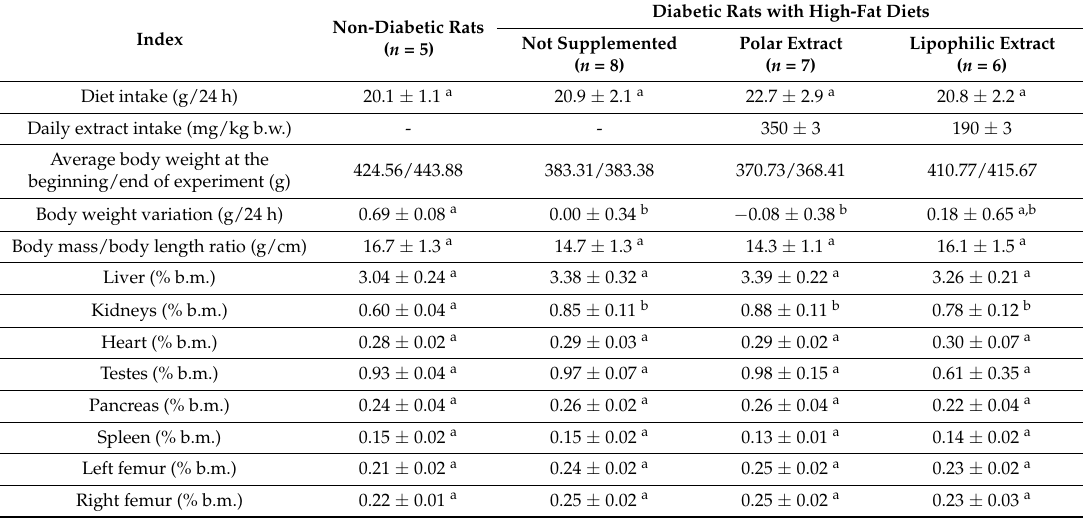
Table 4. Effects of dietary supplementation of elderberry polar and lipophilic extracts on the rats’ overall growth indices. Diabetic rats without dietary supplementation and non-diabetic rats were also